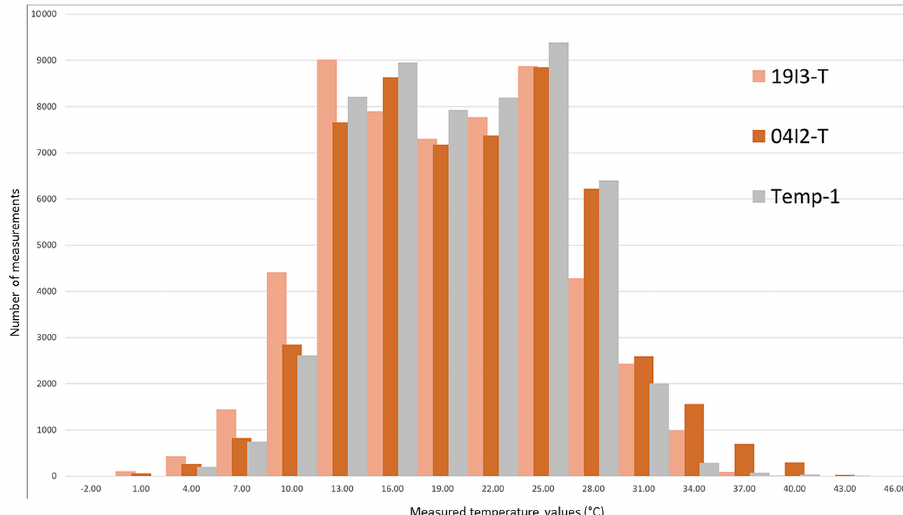
Figure 9. Data distribution of measurements of thermistors (19I3-T, 04I2-T and